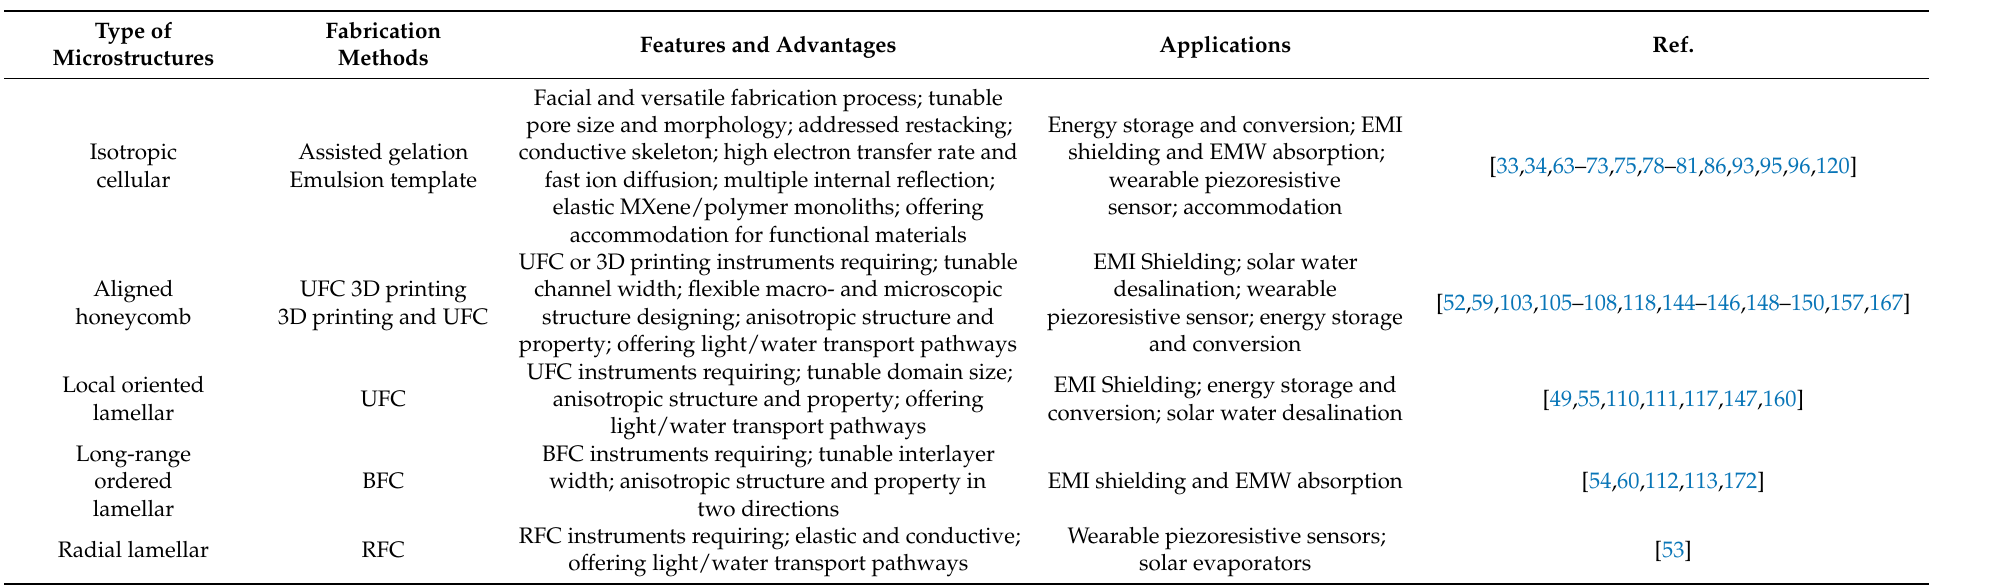
Table 2. Summary of MXene-based porous monoliths in terms of the type of microstructures, fabrication methods, features and advantages, and